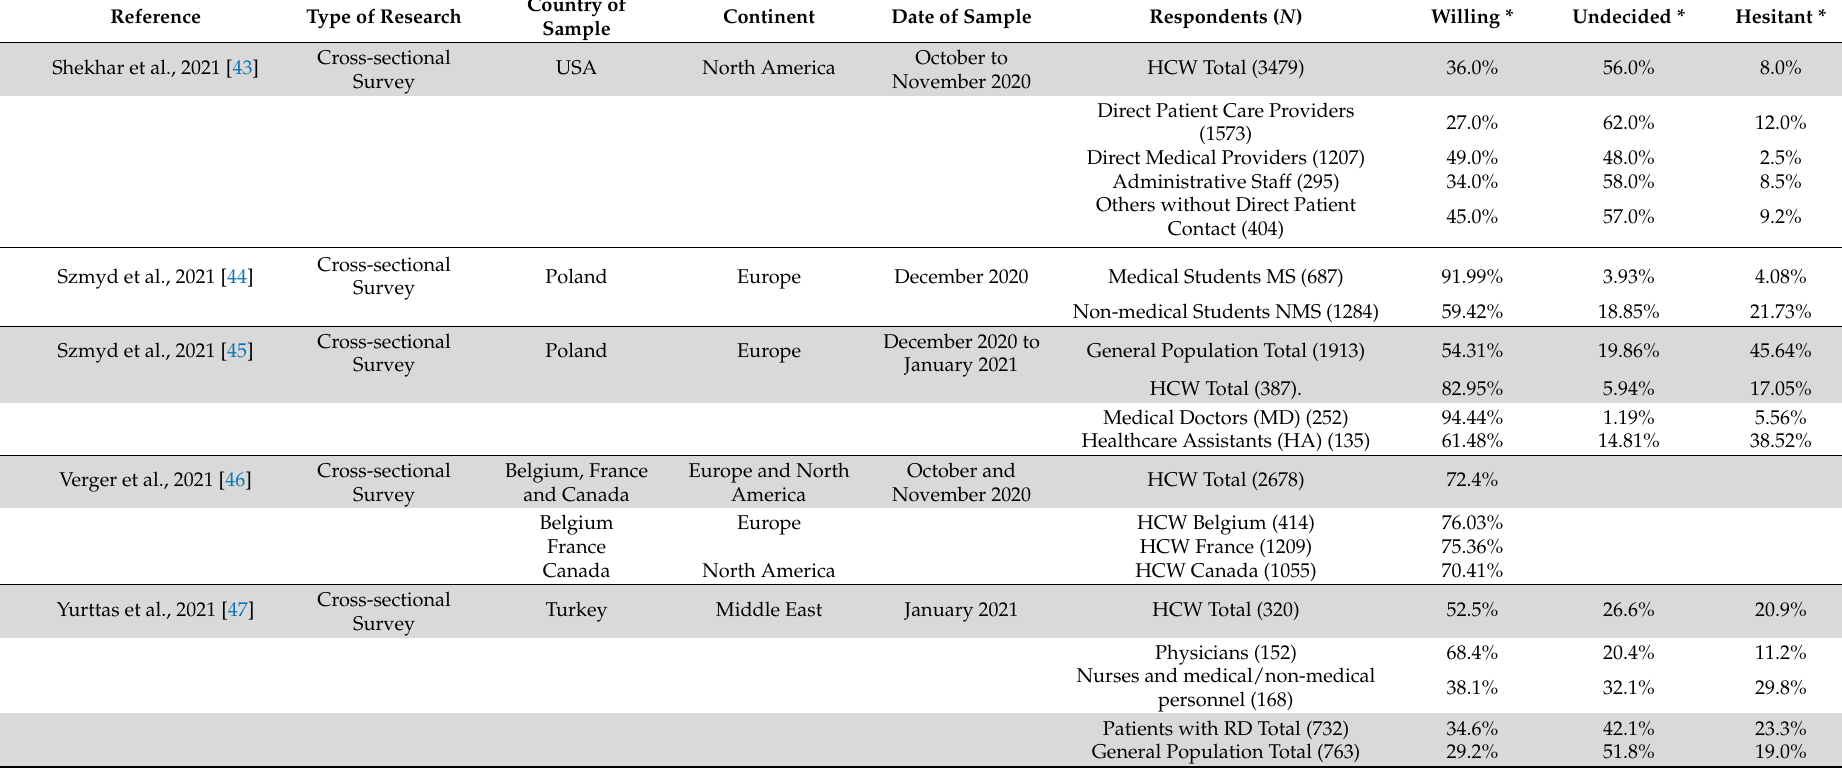
DRC = The Democratic Republic of the Congo. Papers with multiple rows are banded according to respondents’ sample range: dark rows are total samples; light rows are sub-samples. Dotted lines mark a sample range change within the paper: total sample row or sub-sample row. * Percentage is only noted if reported in the paper; µ Paper is a pre-print; α Repeated measure with the same sample after an intervention. β Repeated measure with smaller sample after two